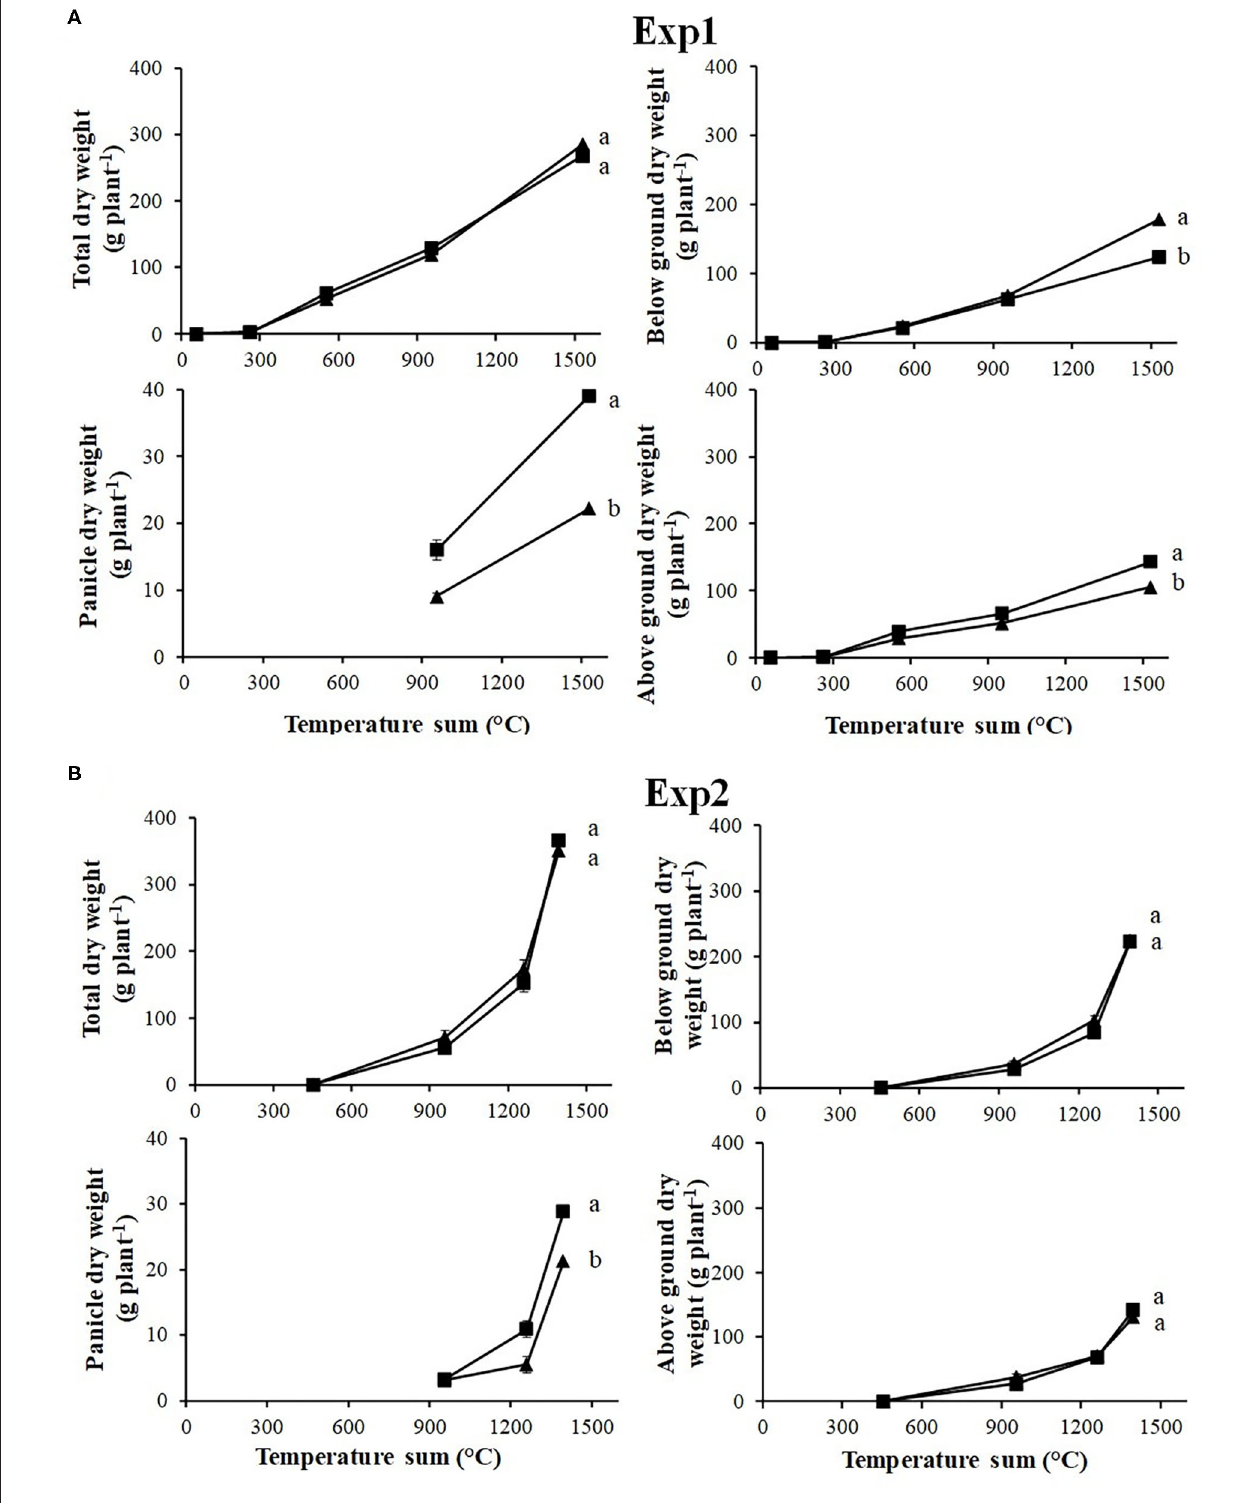
FIGURE 1 | Evolution of total dry weigh and dry weight of the different plant parts during the life cycle recorded for (A) Exp1 and (B) Exp2. Resistance status: S ( (cid:4) ) and R ( N ). Vertical bars represent standard errors. Different letters indicate significant differences ( P ≤ 0.05) according to Fisher’s LSD test.